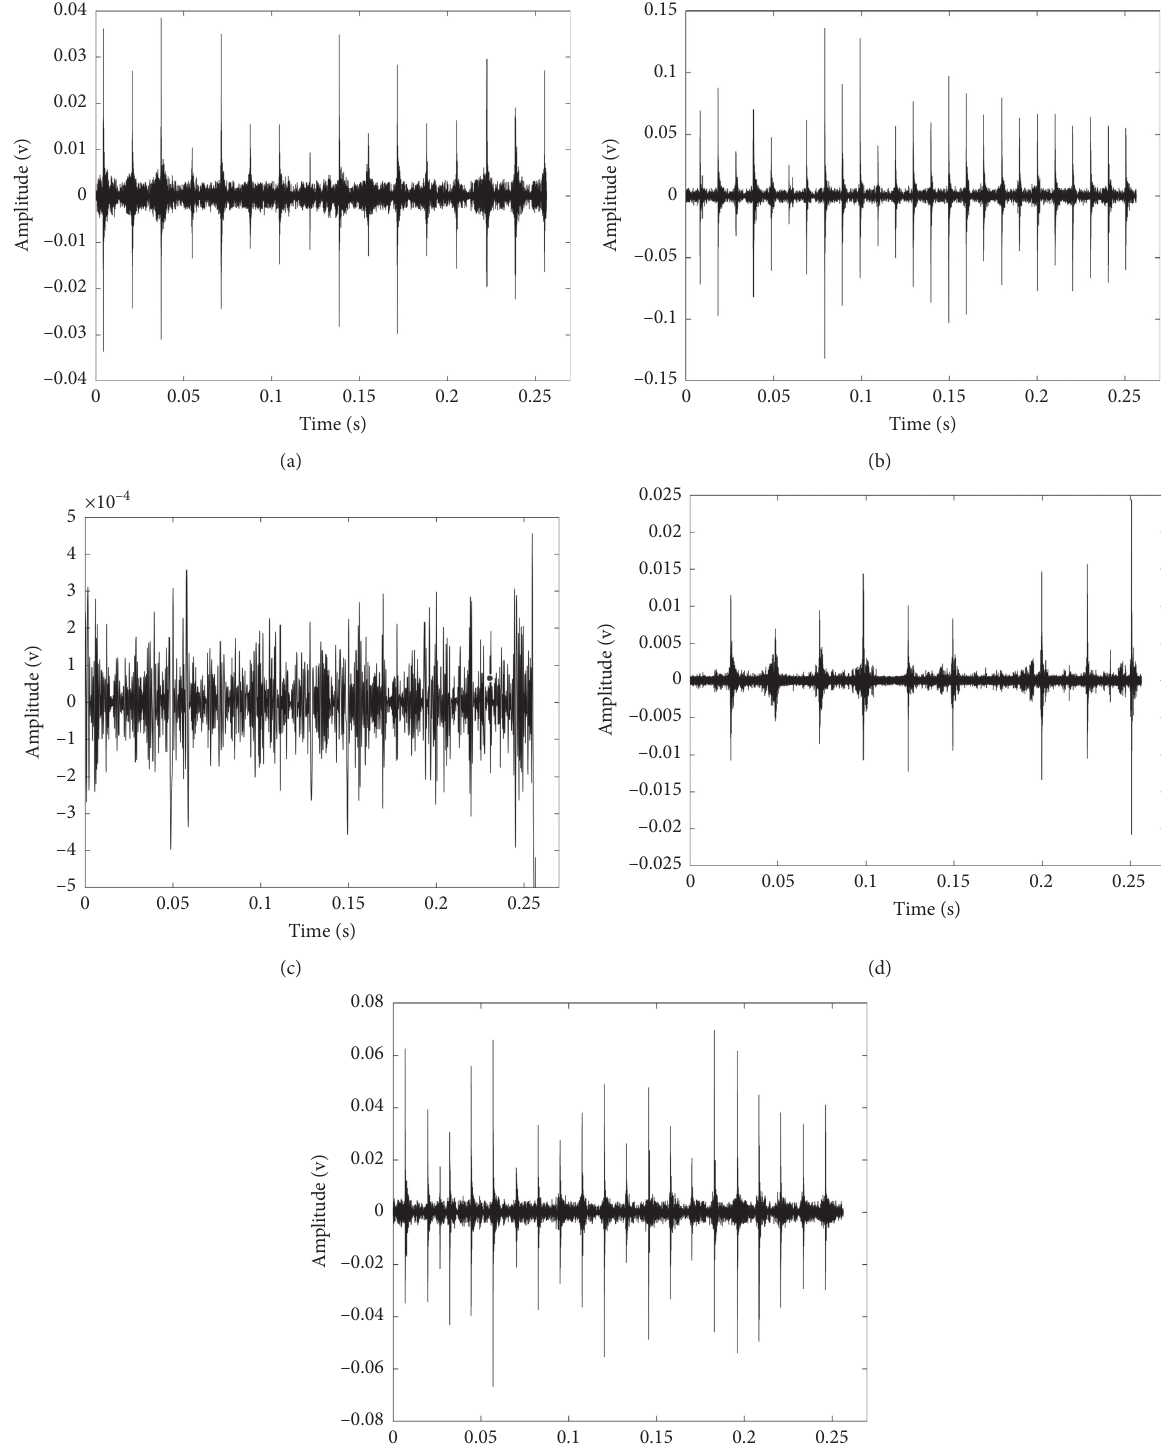
Figure 11: The denoised signals for other conditions. (a) Small defect, medium-low load, and 900rpm. (b) Small defect, medium-high load, and 1500rpm. (c) Large defect, small load, and 600rpm. (d) Large defect, medium-high load, and 600rpm. (e) Large defect, high load, and